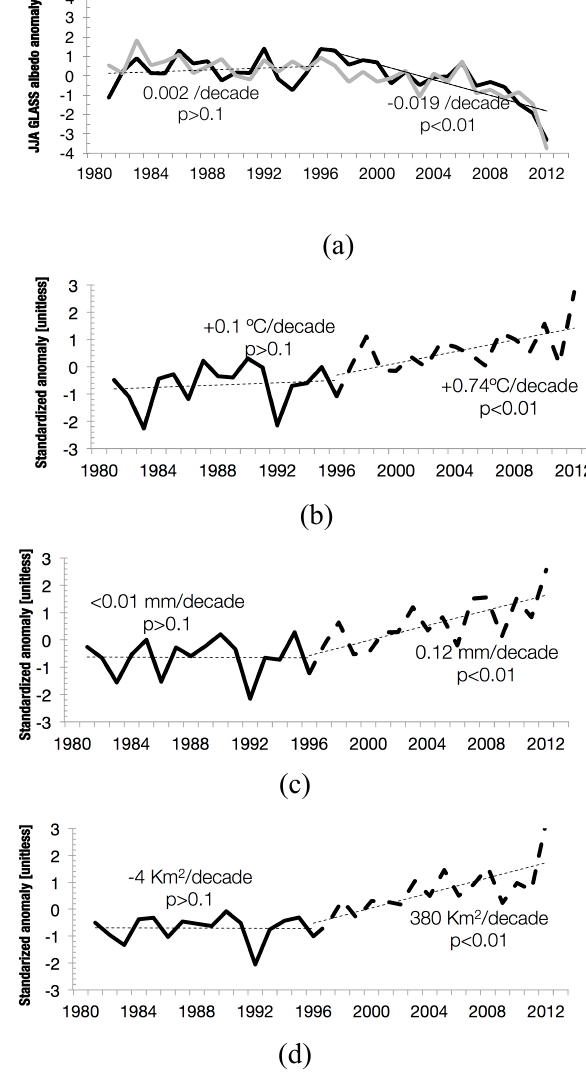
Figure 1. Mean summer standardized values plotted as time se- ries for (a) albedo from GLASS (black) and MAR (grey), together with MAR-simulated values of (b) surface air temperature, (c) sur- face grain size (effective radius of optically “equivalent” sphere), and (d) bare ice exposed area. Trends for the periods 1981–1996 and 1996–2012 are reported in each plot. Trends in (a) refer to the GLASS albedo. The baseline 1981–2012 period is used to compute standardized anomalies, obtained by subtracting the mean and then dividing by the standard deviation of the values in the time series. All trends are computed from JJA averaged values over ice-covered areas only, not